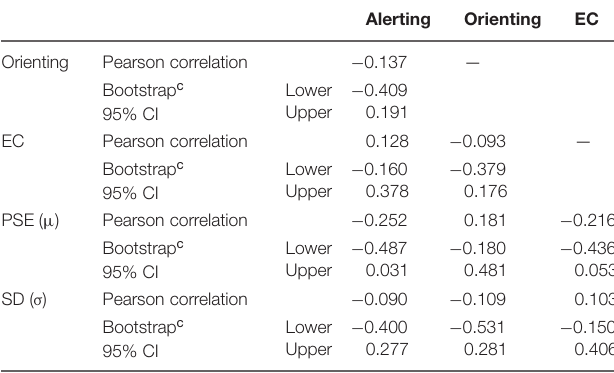
TABLE 2 | Correlations between the three functions of attentional networks in Experiment 2.